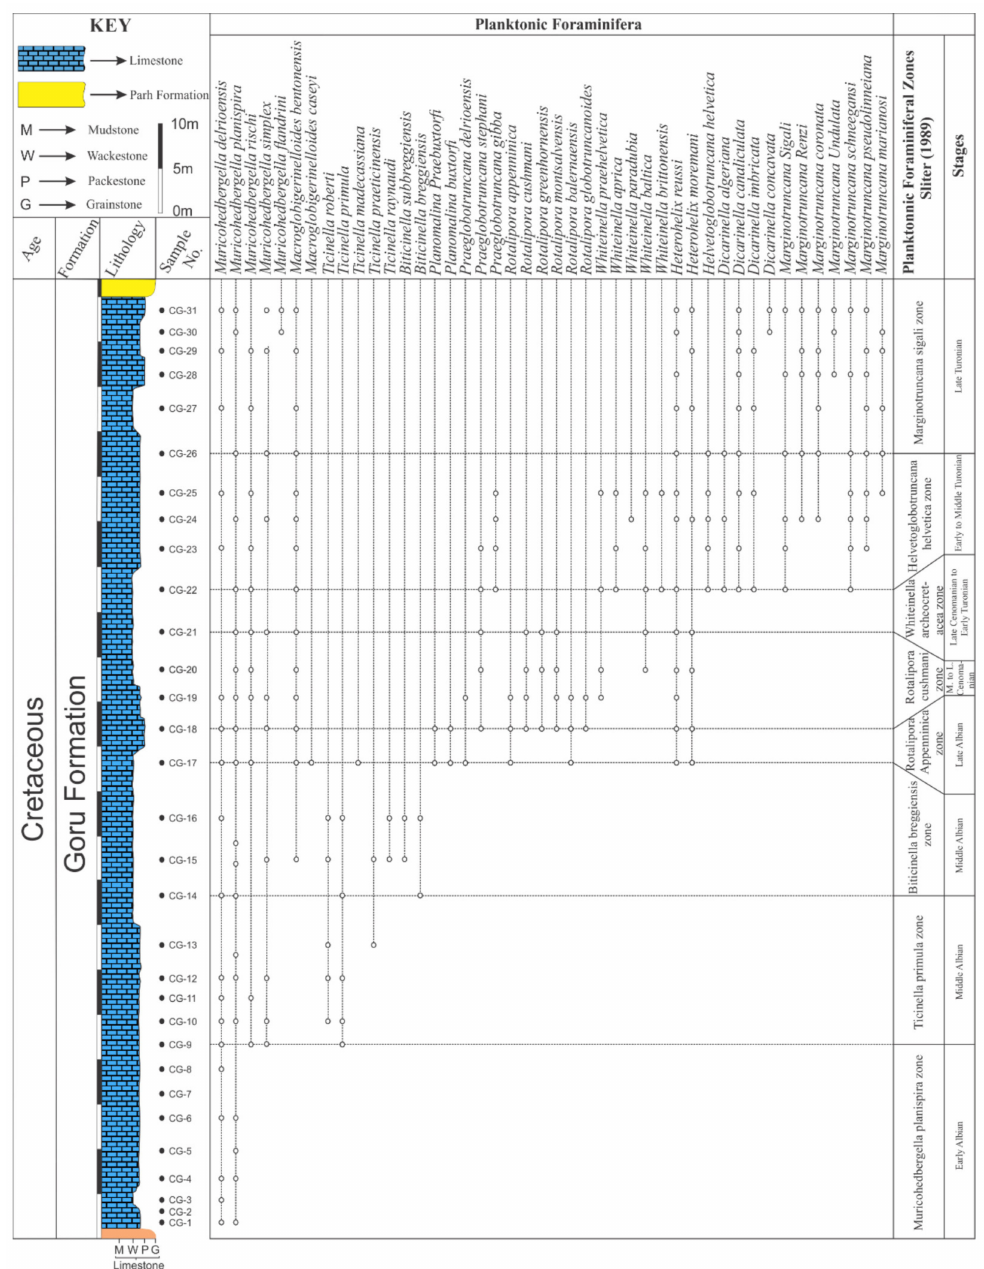
Figure 4. Biostratigraphic range chart of the Goru Formation exposed in the Chutair Section, Sulaiman